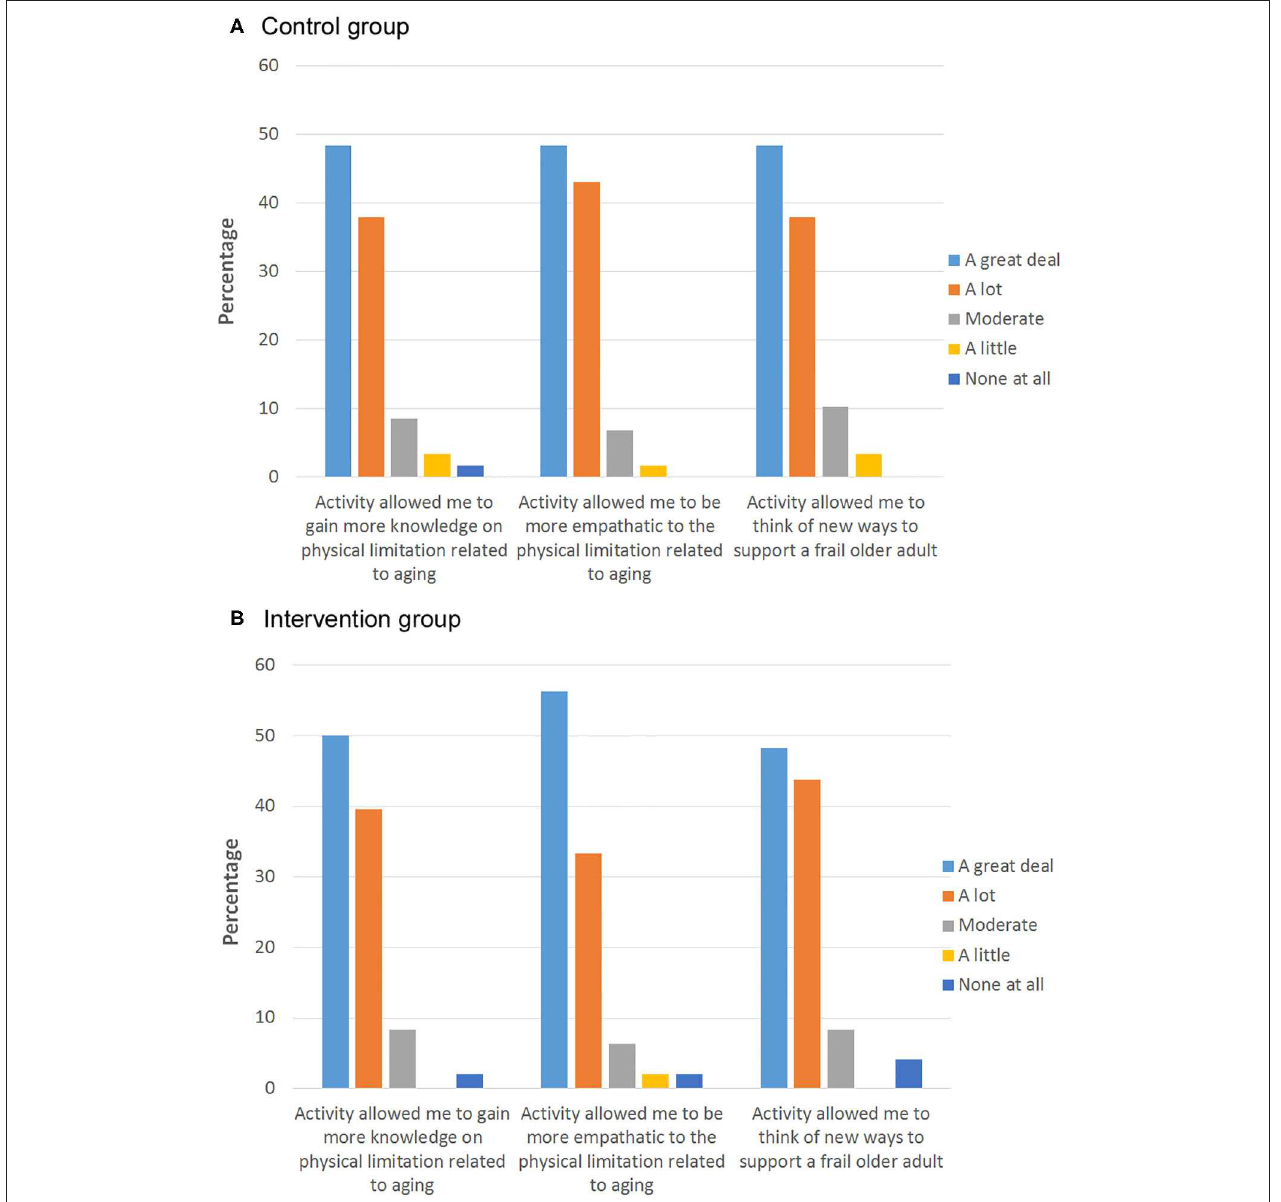
FIGURE 5 | Participants’ reported change in attitude, empathy level, and understanding of older adult in the (A) control group and (B) intervention group after the activity. Bar chart represents the percentage of